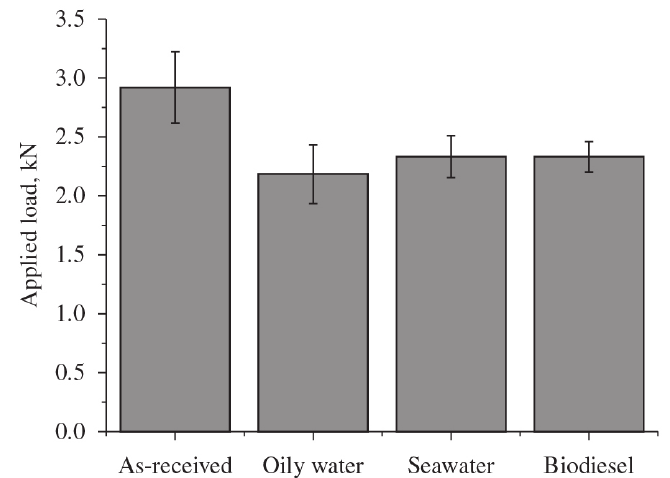
Figure 3. Load necessary to reduce the specimen’s diameter by 10% of its original